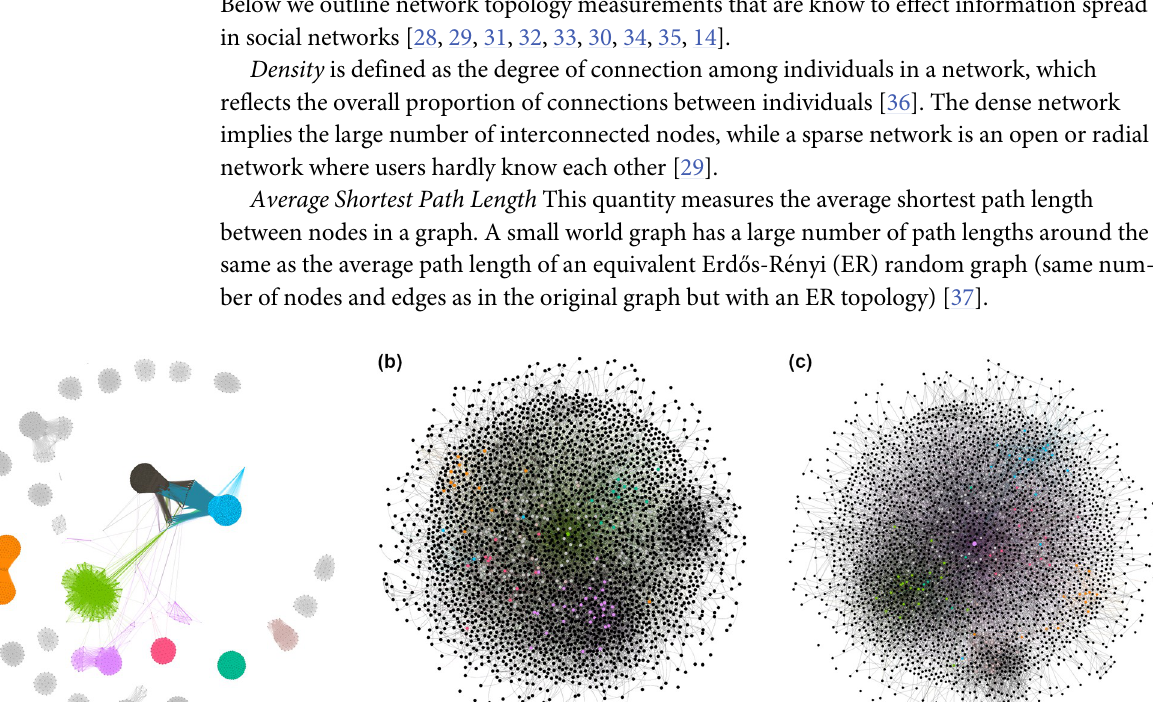
PLOS ONE | https://doi.org/10.1371/journal.pone.0230250 March 24,